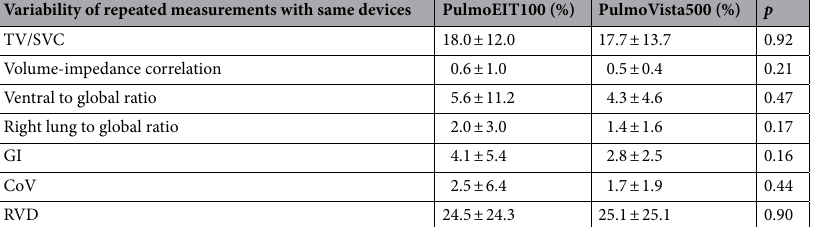
Table 1. Variability of EIT measures from the same device. TV tidal impedance variation, SVC impedance variation during SVC maneuver, GI the global inhomogeneity index, CoV center of ventilation, RVD regional ventilation